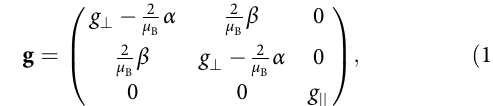
Fig. 3 Measurement time dependence. a Long-time (50 min) averaged measurements of singlet return signal as a function of manipulation time for several magnetic fi eld strengths aligned along the ½ 110 (cid:2) crystallographic direction. The data for each fi eld has been shifted for clarity. b The extracted T ? function of total experimental measurement time. (inset) Magnetic noise creates fl uctuations in the effective magnetic fi eld at each QD, leading to variation in the X -rotation frequency throughout the measurement. c Relevant time scales of the measurement. The shortest time scale susceptible to noise in the experiment is the time spent manipulating the qubit. In the limit of quasi-static noise, we expect the qubit to have a constant environment during this time. However, over the course of a total pulse cycle (which consists of qubit preparation and measurement and may be several ms in length), the environment may change. Furthermore, as the cycle is repeated and averaged by the lock-in for each data point, each data point is collected for a free induction decay curve. As successive curves are averaged together, the distribution of noise that is sampled grows larger. d During the course of the measurement, the qubit is susceptible to noise in the frequency band between 1/ t Total and 1/ t